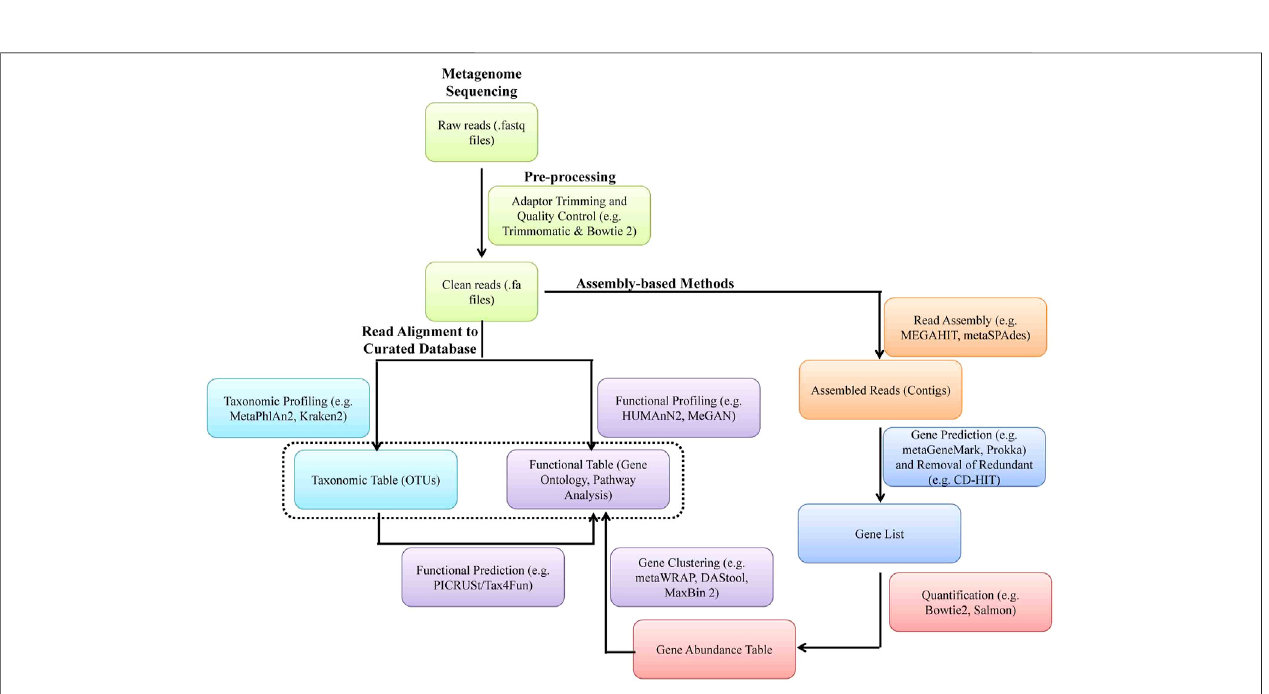
FIGURE 6 | A software pipeline for analysis of whole genome metagenomic sequencing data. Each type of experiment has distinct requirements and challenges but there is a common work fl ow/pipeline.